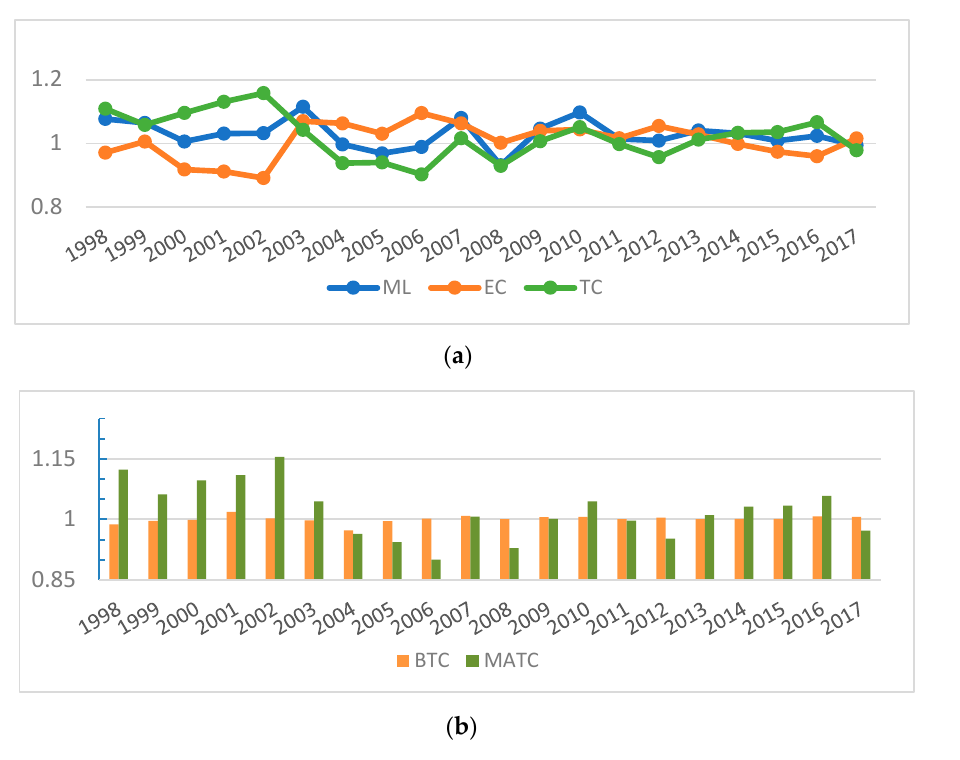
Figure 2. ( a ) Agricultural GTFP index and its decomposition; ( b ) TC index and its decomposition. Table 4. Measurement results of BTC index decomposition of each